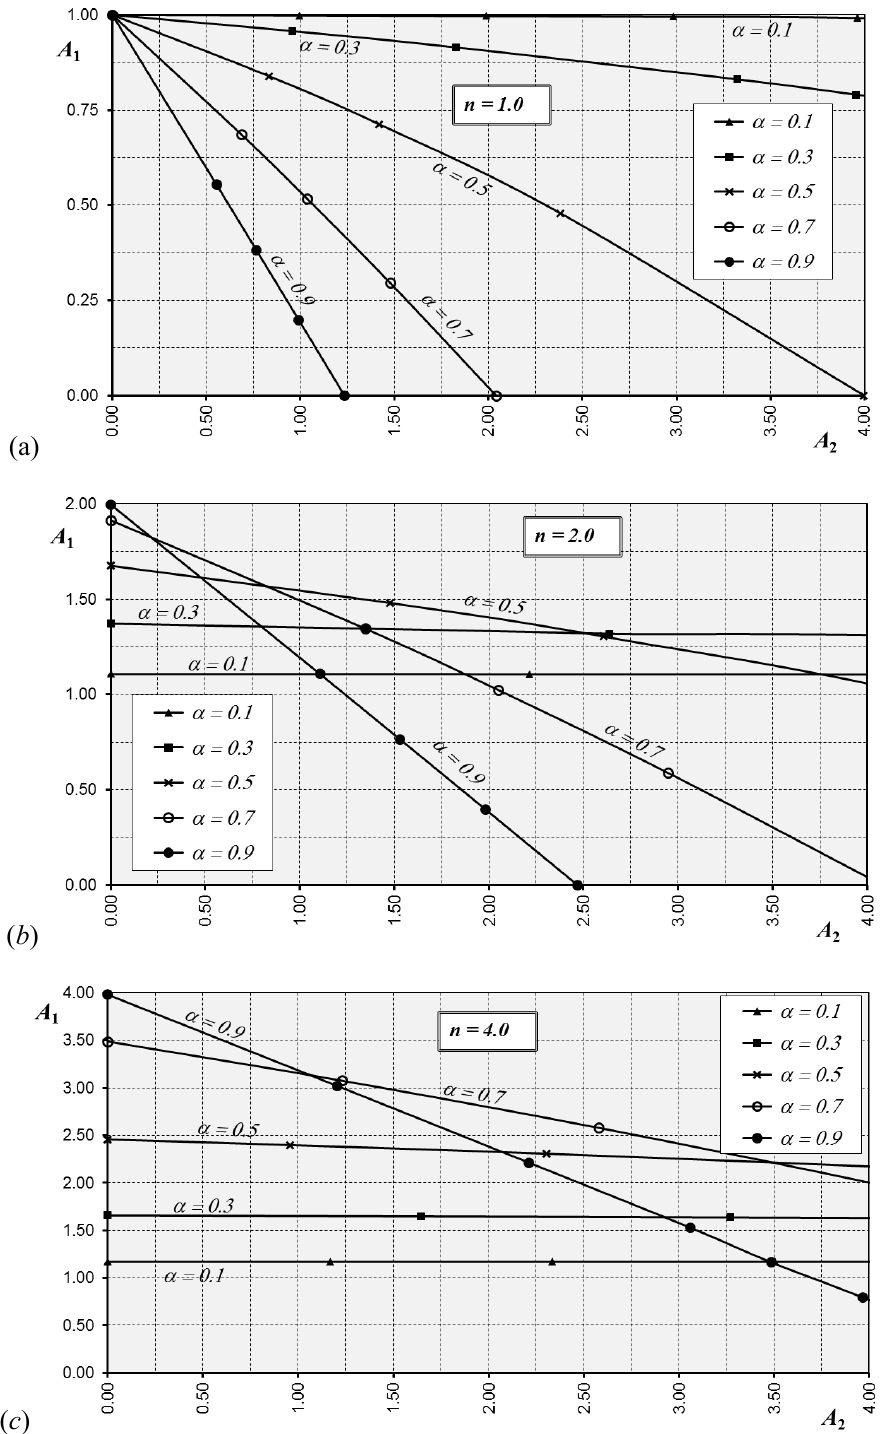
Fig. 6. Bucking loads parameters of columns with clamped - free ends (C-F) under intermediate load P and end load P 2 1 (a) n=1.0, (b) n=2.0 and (c)